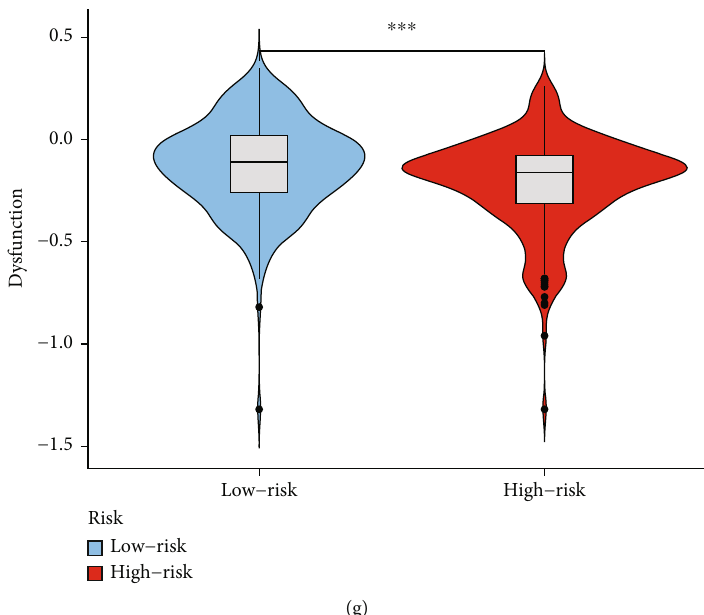
Figure 7: Immunity-related analyses. (a) ESTIMATE score of stromal cells. (b) ESTIMATE score of immune cells. (c) In fi ltration score of immune cells. (d) Activity of immunity-related function and pathways. (e) Expression of 29 immune checkpoints. (f) TIDE score. (g) Dysfunction